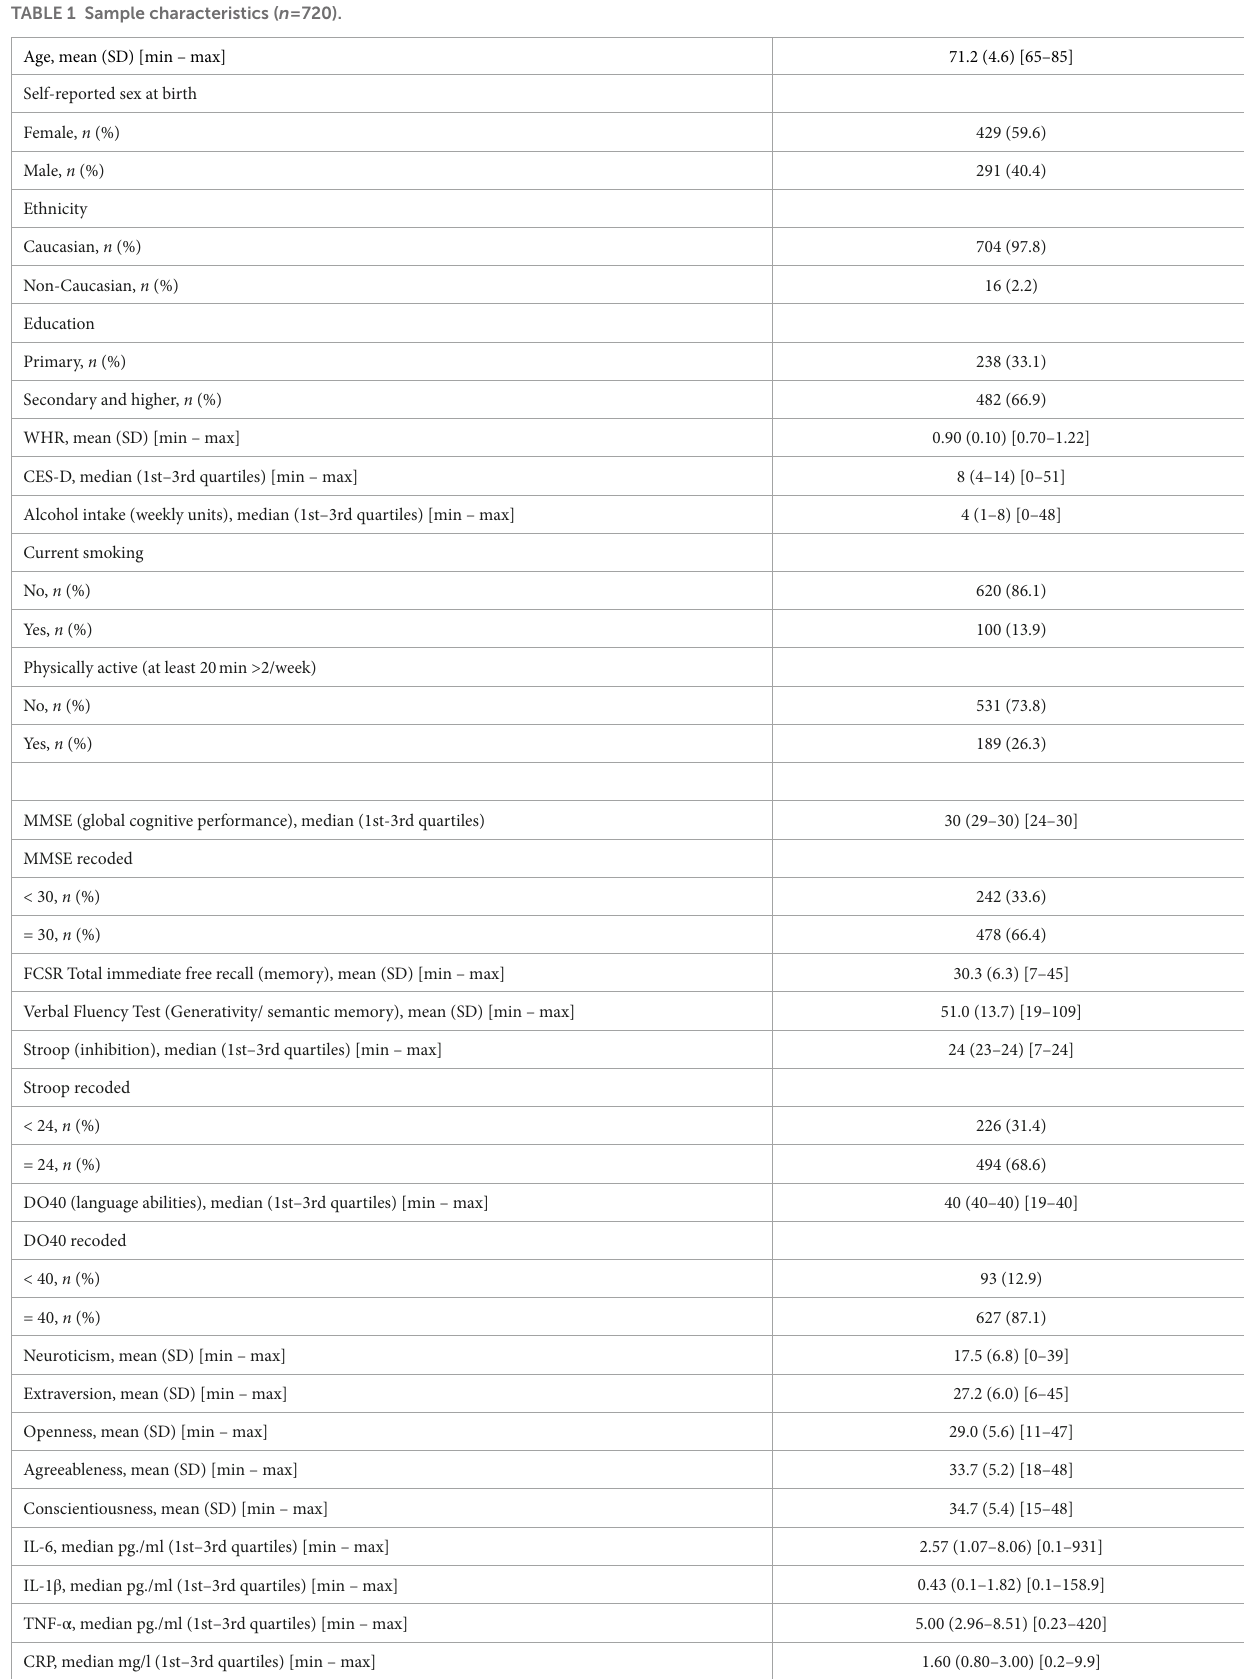
TABLE 1 Sample characteristics ( n =